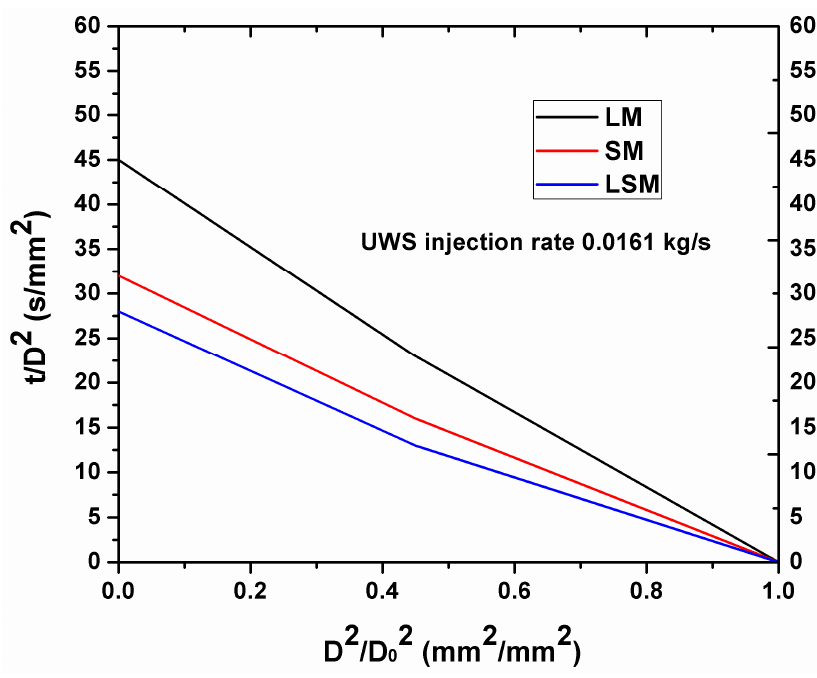
Figure 11. Urea water solution (UWS) droplet at two vaporization stages.